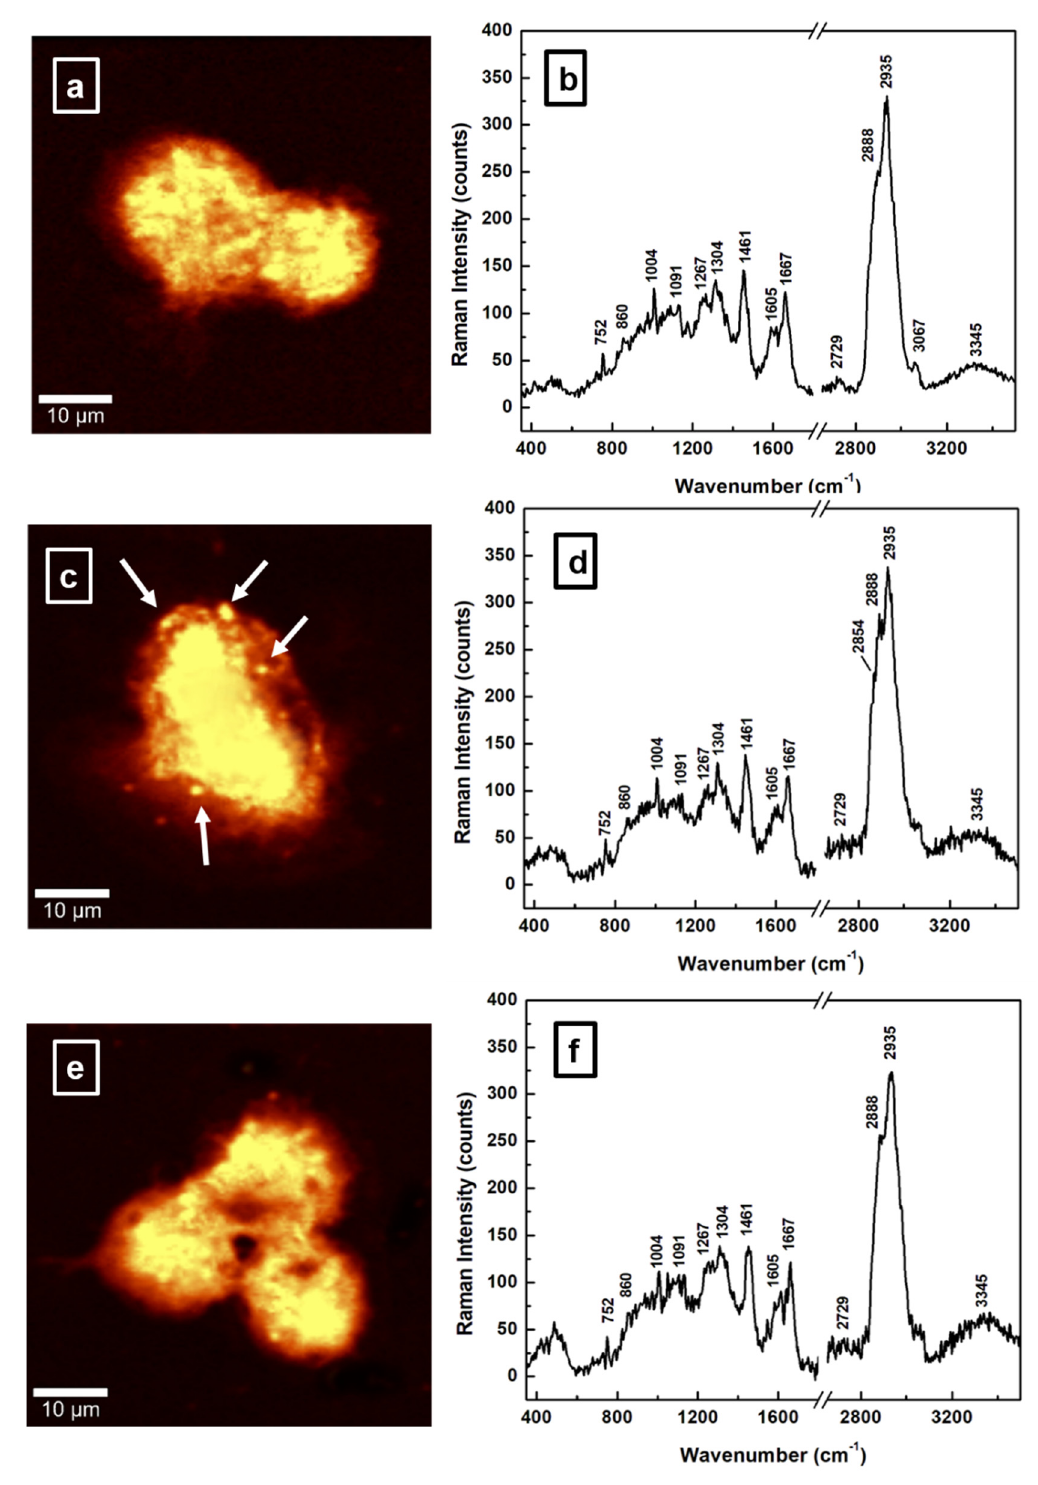
Figure 2. ( a – f ). Representative images acquired with surface confocal Raman mapping of: ( a ) untreated (control) GBM cells, ( c ) 100 µ M NDGA-treated GBM sample treated for 24 h, and ( e ) 250 µ M NDGA-treated GBM sample treated for 4 h. A bright yellow pseudo-color corresponds to a higher intensity. ( b , d , f ) Raman spectra associated with each image and only in vibrational regions of interest.